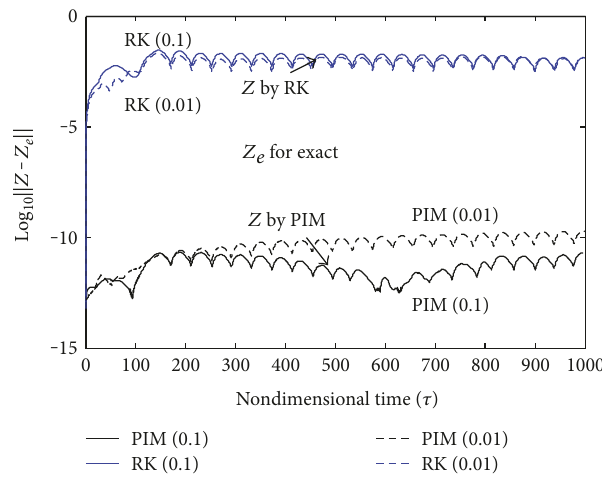
Figure 8: Logarithmic errors of RK or PIM result with respect to the exact solutions of the aeroelastic system at U / U direction.